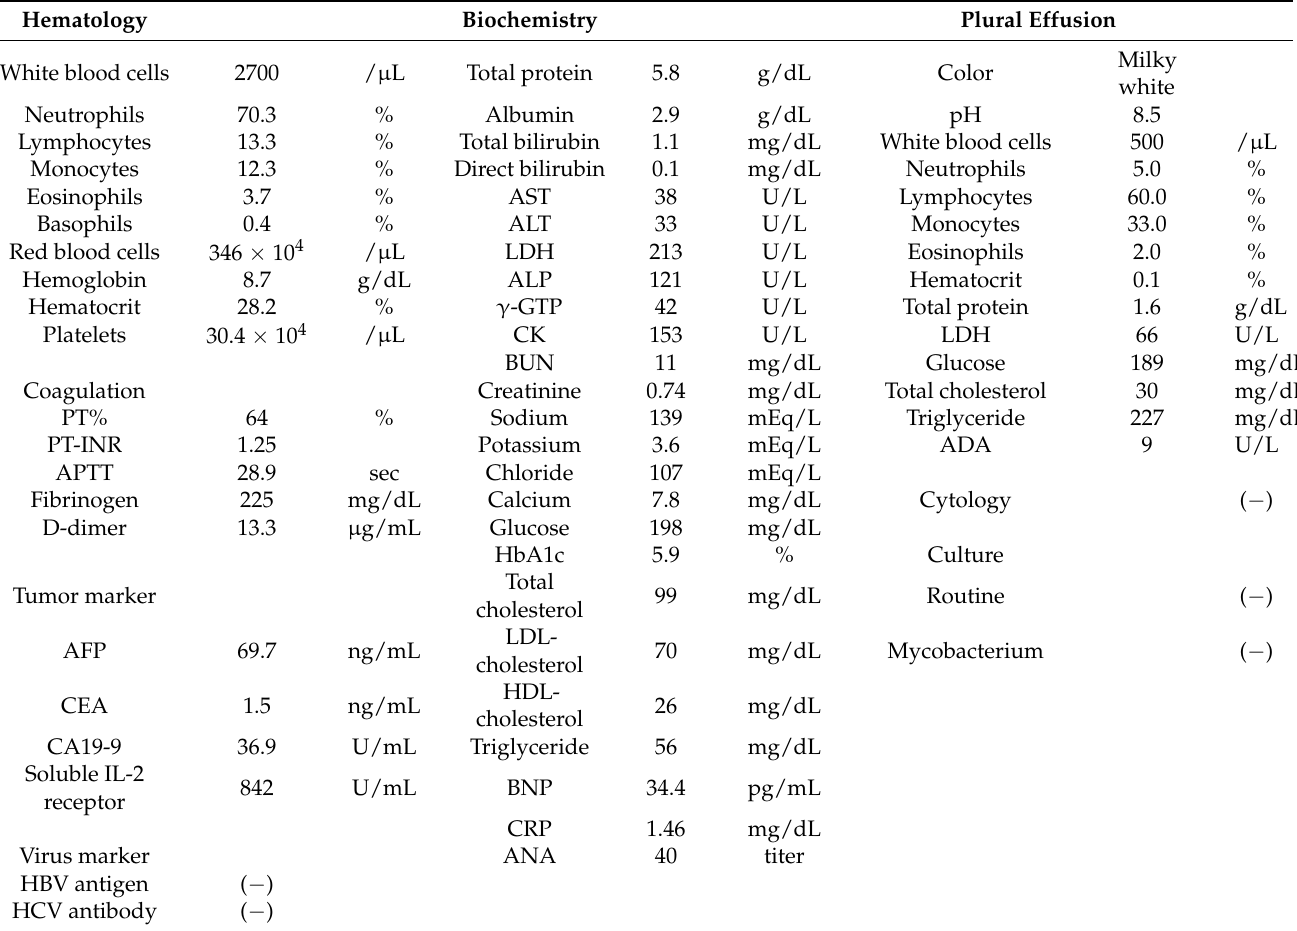
Table 1. Laboratory data at the first